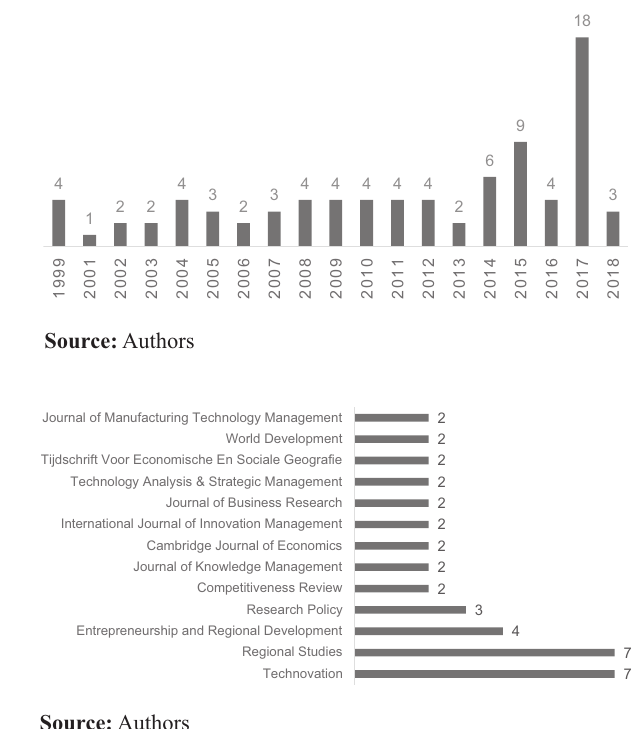
Figure 4. Main journals